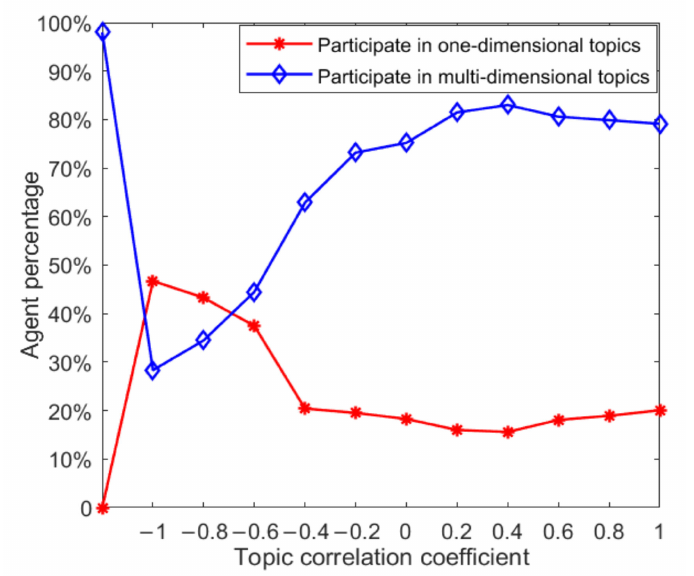
Figure 7. The influence of topic correlation coefficient on the number of topics that individuals participate